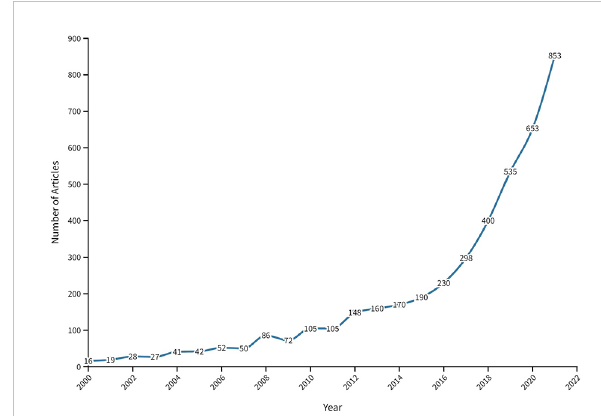
FIGURE 1 Annual number of cancer research publications in FCS in the MENA region from 2000 to 2021.